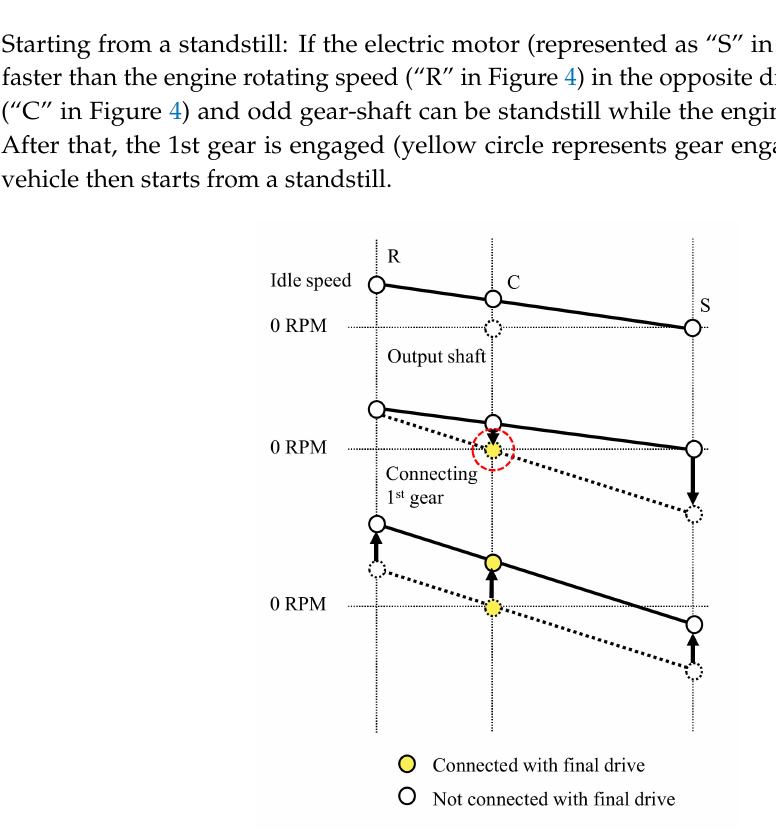
Figure 4. Lever analogy for describing starting from a standstill (R: Ring gear, Engine, C: Carrier gear, S: Sun gear, Electric Motor).